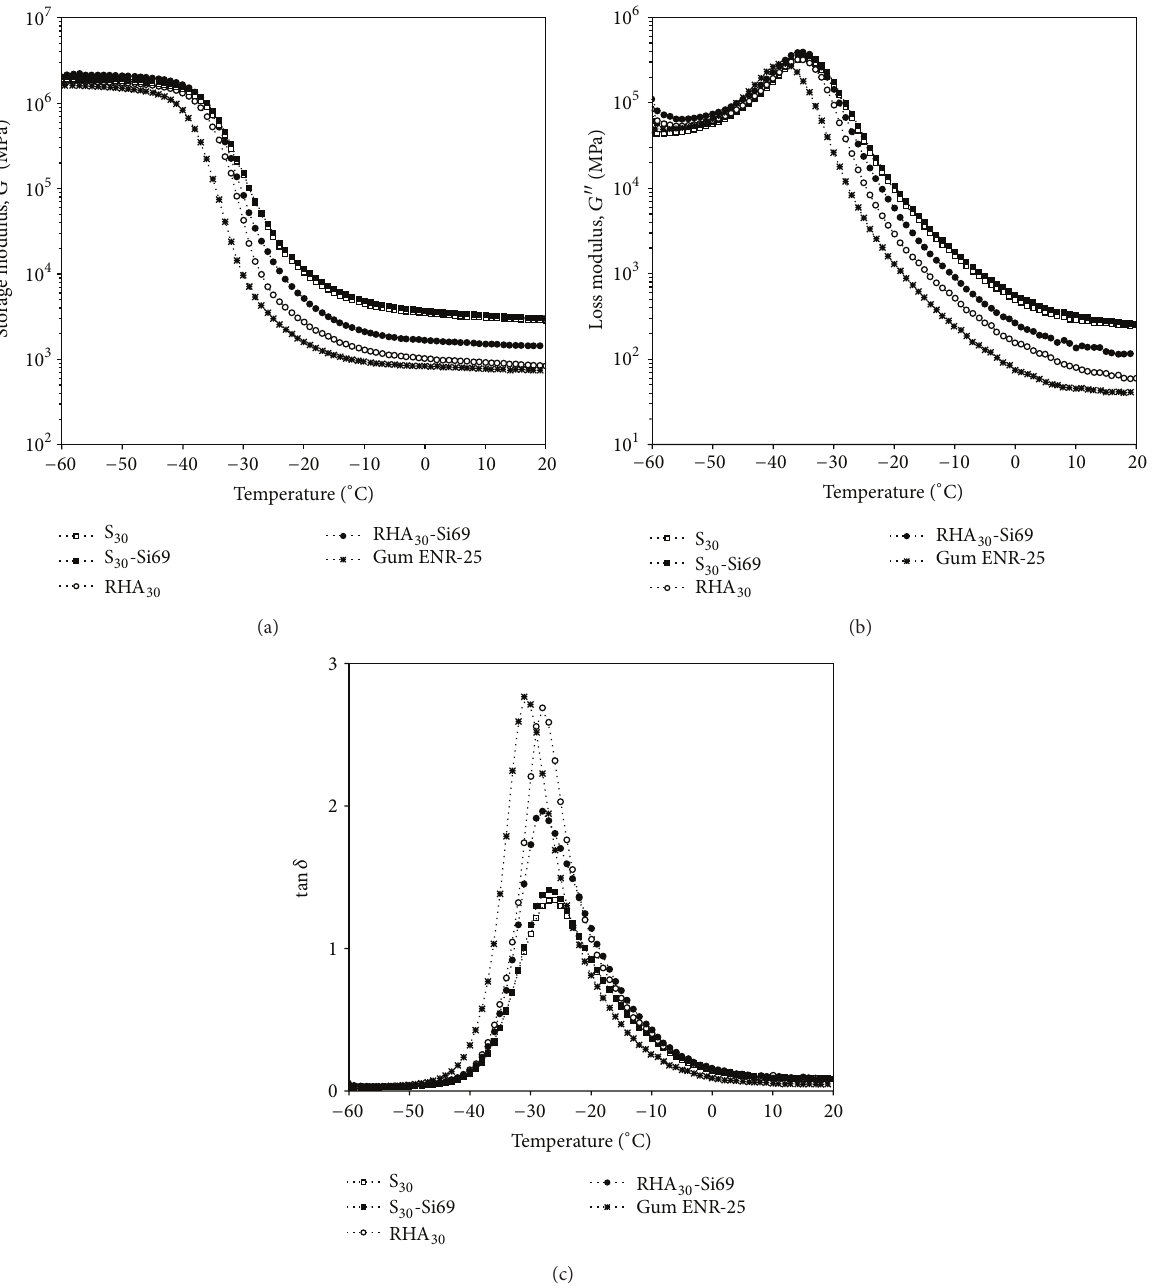
Figure 10: (a) Storage modulus, (b) loss modulus, and (c) tan 𝛿 as a function of temperature of ENR-25 gum and filled vulcanizates with 30 phr of RHA and silica with and without silane coupling agent